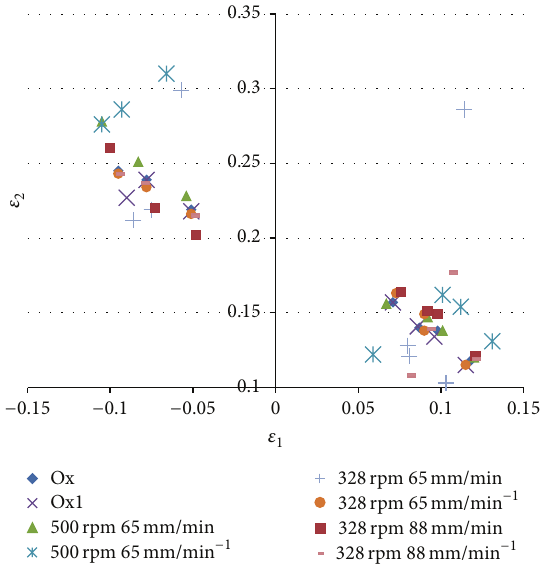
Figure 33: FLD diagram results for MSC-MARC.